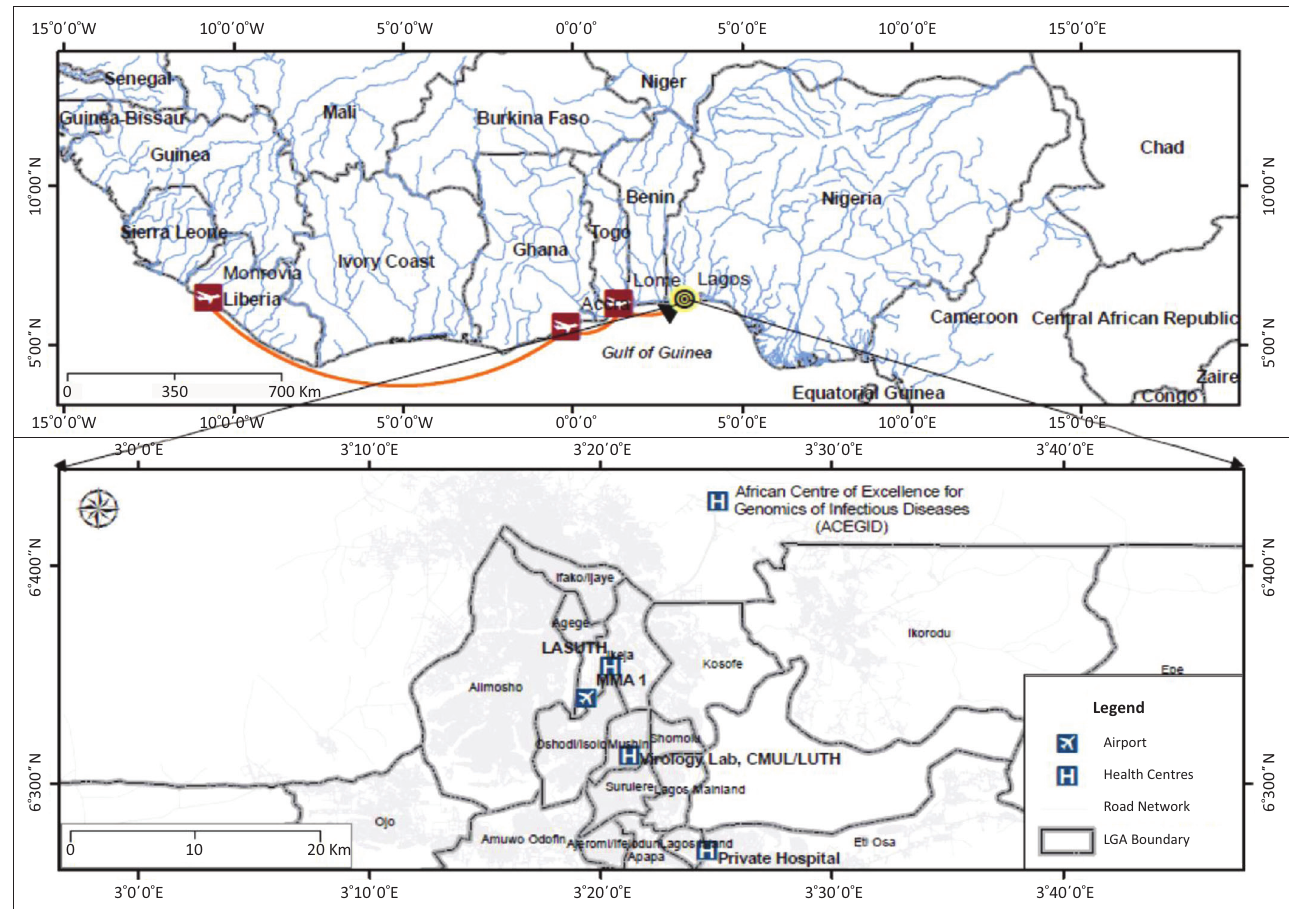
FIGURE 1: Travel route of index case with Ebola virus disease from Liberia to Lagos, Nigeria. Lower inset shows the closest health care facility to the airport (LASUTH), the private health care facility where the index case was admitted (Private Hospital), the Laboratory where the diagnosis was made (Virology Lab, CMUL/LUTH) and the Genomics Centre where the corroborative diagnosis and nucleotide sequencing was done (ACEGID). Map was plotted with GPS coordinates using Arc GIS 10.1.